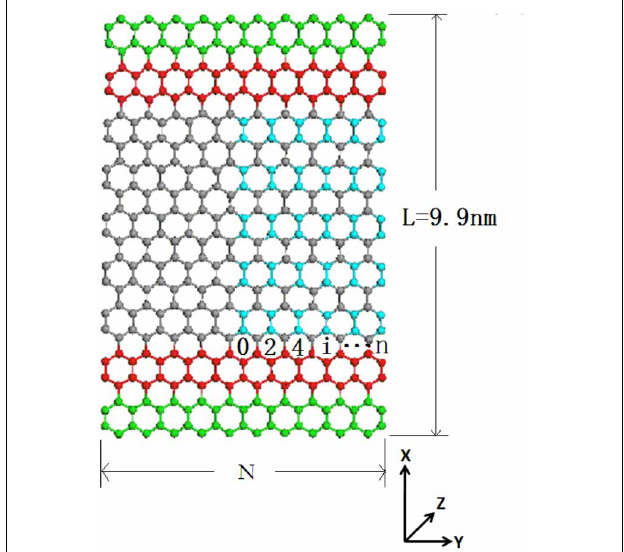
FIGURE 1 | Schematic picture of the graphene nanoribbon. The last layers of atoms at the two ends (in green) are fixed, and the atoms (in red) next to the fixed layers are placed in thermostats. Here “0” line corresponds to the central dimer of GNR, and “ n ” line is the edge dimer, with N = 2 × n + 1.